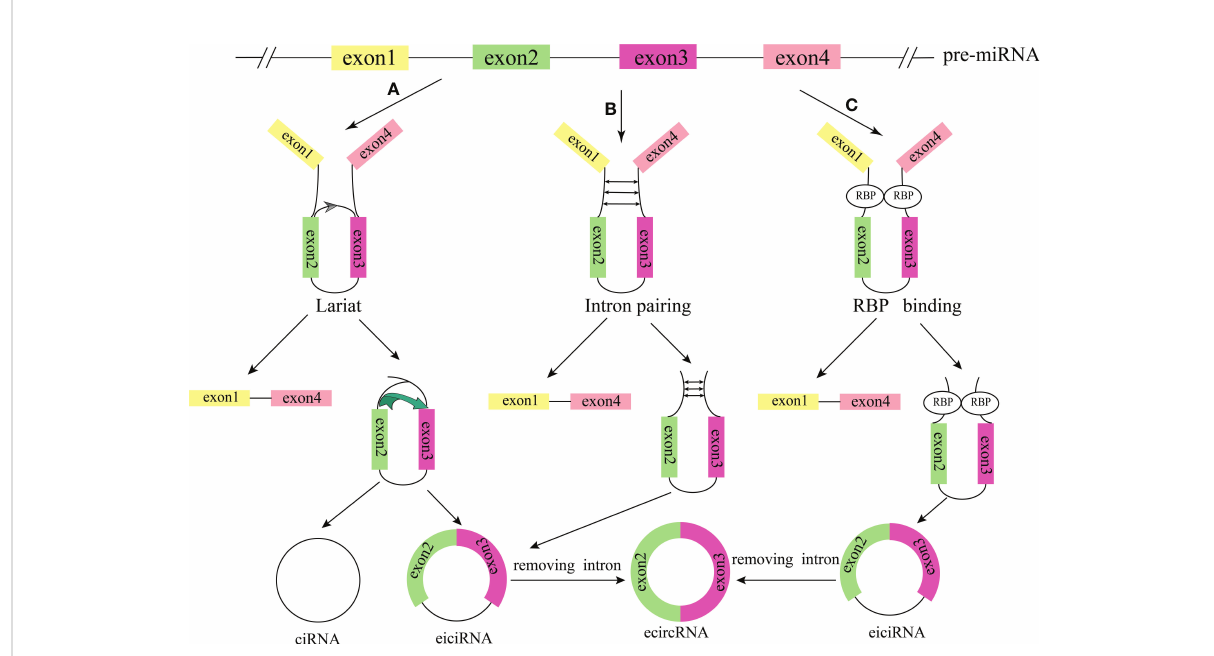
FIGURE 1 The formation process of the circRNAs. (A) Cyclization driven by lariat. (B) Intron pairing drives cyclization. (C) RBP was combined with cyclization to form a bridge. The pre-mRNA was spliced to produce an mRNA composed of exon 1 and exon 4 and an RBP binding RNA containing exons 2 and 3, and then generated ciRNA and eiciRNA. EiciRNA removed intron to form